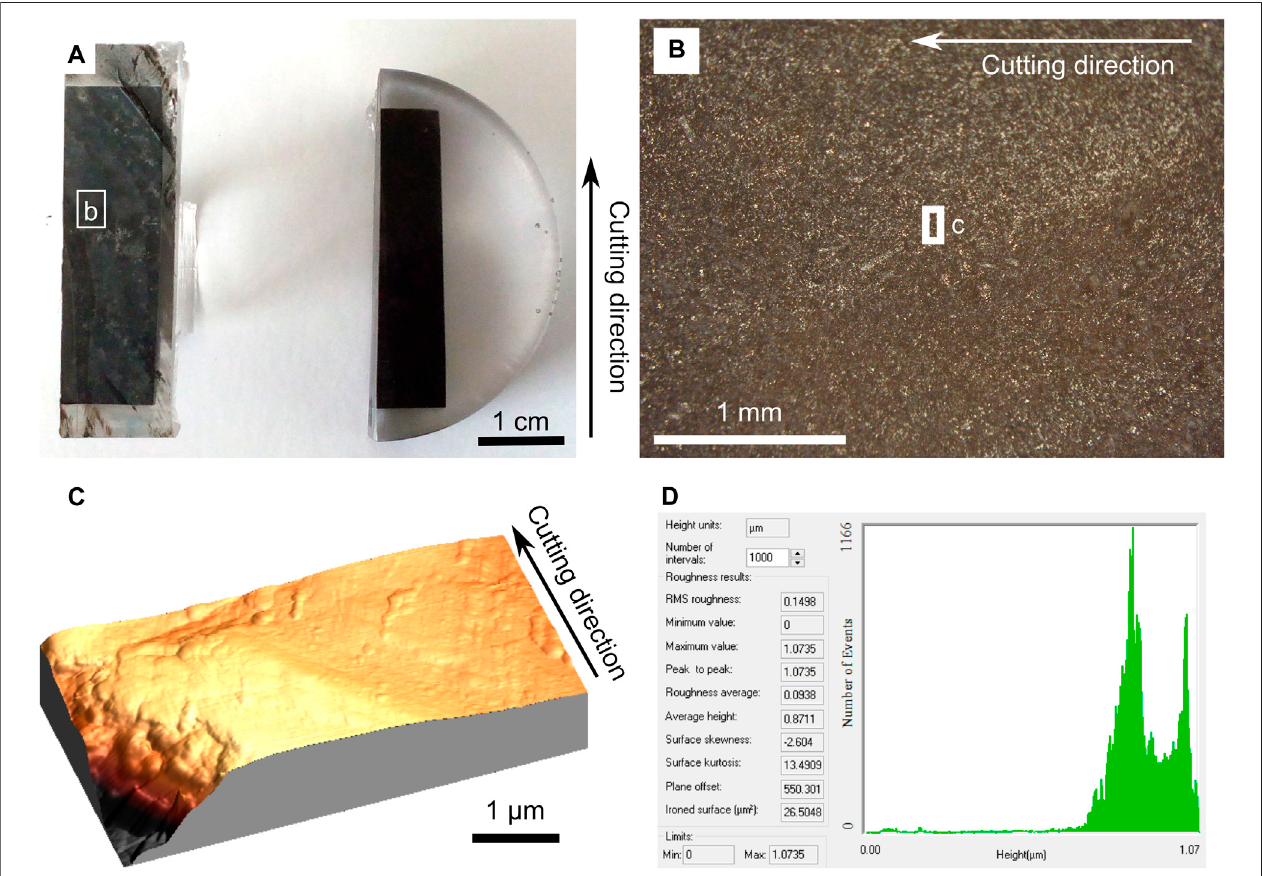
FIGURE 8 | Basalt sample after cutting with the Struers Secotom-10 disc saw. (A) Photograph of the two parts of the sample. (B) Optical microscopy image in re fl ected light of the area indicated in (A) . (C) AFM image of the areas indicated in (B,D) associated roughness measurement.